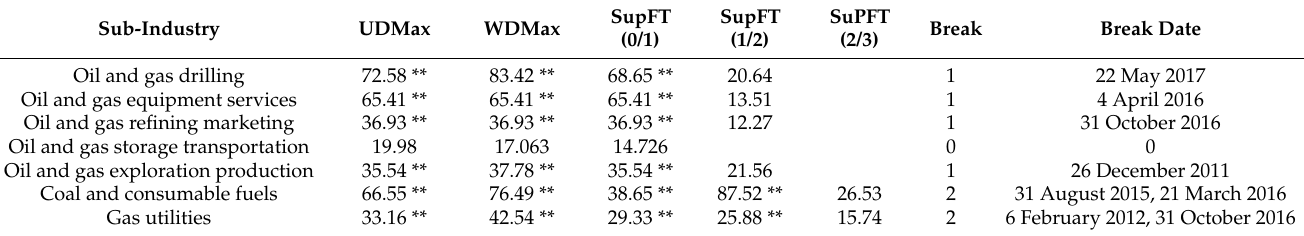
Table 3. Results for the structural breaks